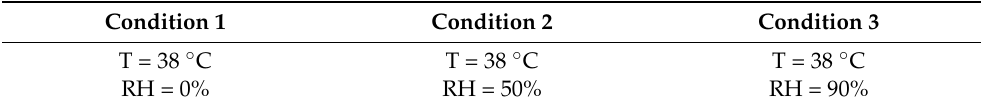
Table 1. Environmental conditions used for conditioning the pellets and the compression- molded